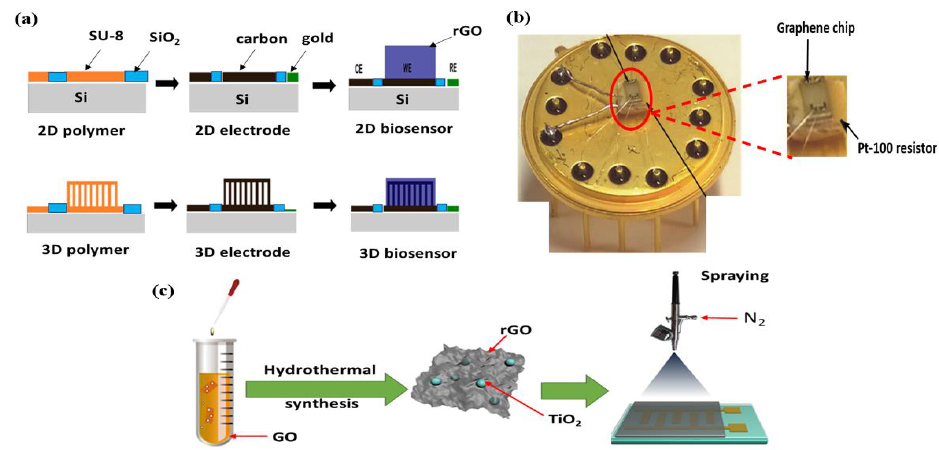
Figure 4. ( a ) Schematic illustration of 2D and 3D carbon-based biosensors, reproduced with permission from [97], published by MDPI, 2018; ( b ) graphene-based sensor chip above holder reproduced with permission from [100], published by Elsevier, 2016; and ( c ) synthetic layout of rGO-TiO 2 thin-film sensor, reproduced with permission from [105], published by Elsevier, 2017.